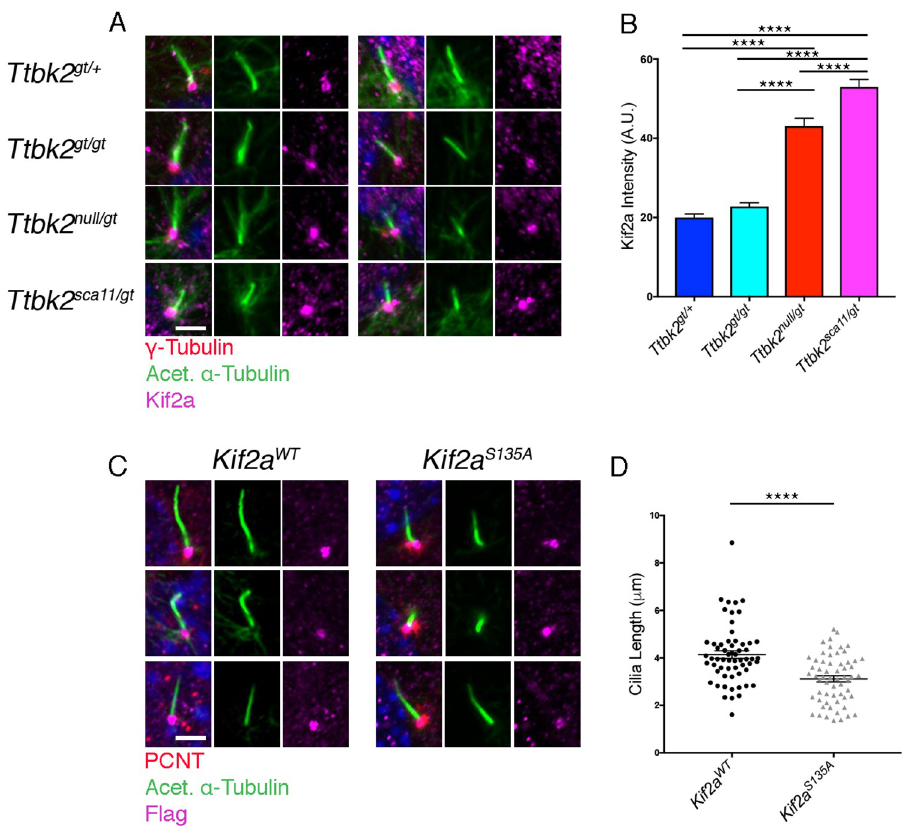
were serum starved for 48 hours. Centrosomes are labeled with γ -Tubulin (red) and cilia are stained for Acetylated α - Tubulin (green). Pixel intensity of KIF2A at the centrosome is quantified in (B). While we detected no significant difference between Ttbk2 gt/+ and Ttbk2 gt/gt , Ttbk2 null/gt and Ttbk2 sca11/gt cells have increased levels of KIF2A at the centrosome, and KIF2A is further increased in Ttbk2 sca11/gt . (1-way ANOVA, p < 0.0001 for all). n = 50 cilia pooled from 3 biological replicates. Scale bar = 5 μ m (C,D) Ttbk2 gt/+ cells were stably expressing either KIF2A WT or a phospho-mutant variant of KIF2A, KIF2A S135A . Immunostaining is shown for the Kif2a construct (magenta), centrosomes stained for PCNT (red), and the ciliary axoneme labeled with Acetylated α -Tubulin (green). Three representative cilia are shown per condition. Cilia were shorter in Ttbk2 gt/+ cells when expressing KIFT2A S135A . Cilia length was determined and quantified in (D) (1-way ANOVA p < 0.0001). Error bars represent